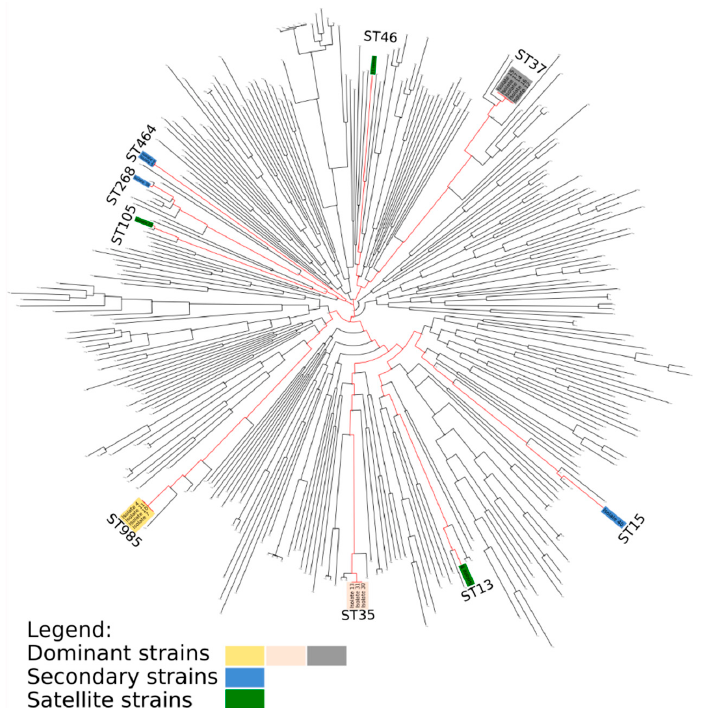
Figure 2. KpI, a major K. pneumoniae phylogenetic group, supplemented with ESBL-producing K. pneumoniae isolates from the neonatal intensive care unit outbreaks reported here. Dominant clones are in yellow, gray, and pink. Secondary and satellite strains are in blue and green, respectively.